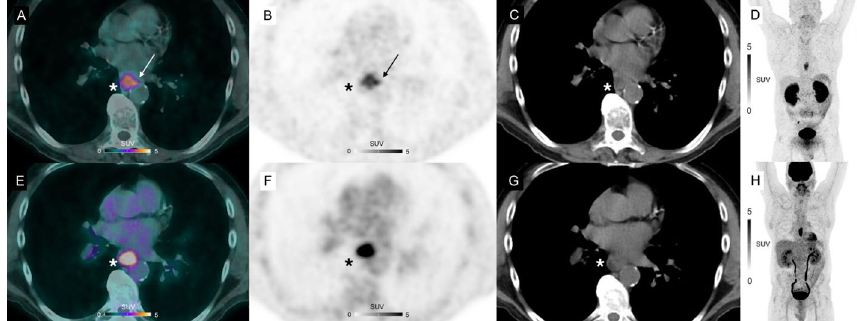
Fig. 4 68 Ga-NODAGA-RGD PET/CT ( A ), PET ( B , D ) and CT ( C ) and 18 F-FDG PET/CT ( E ), PET ( F , H ) and